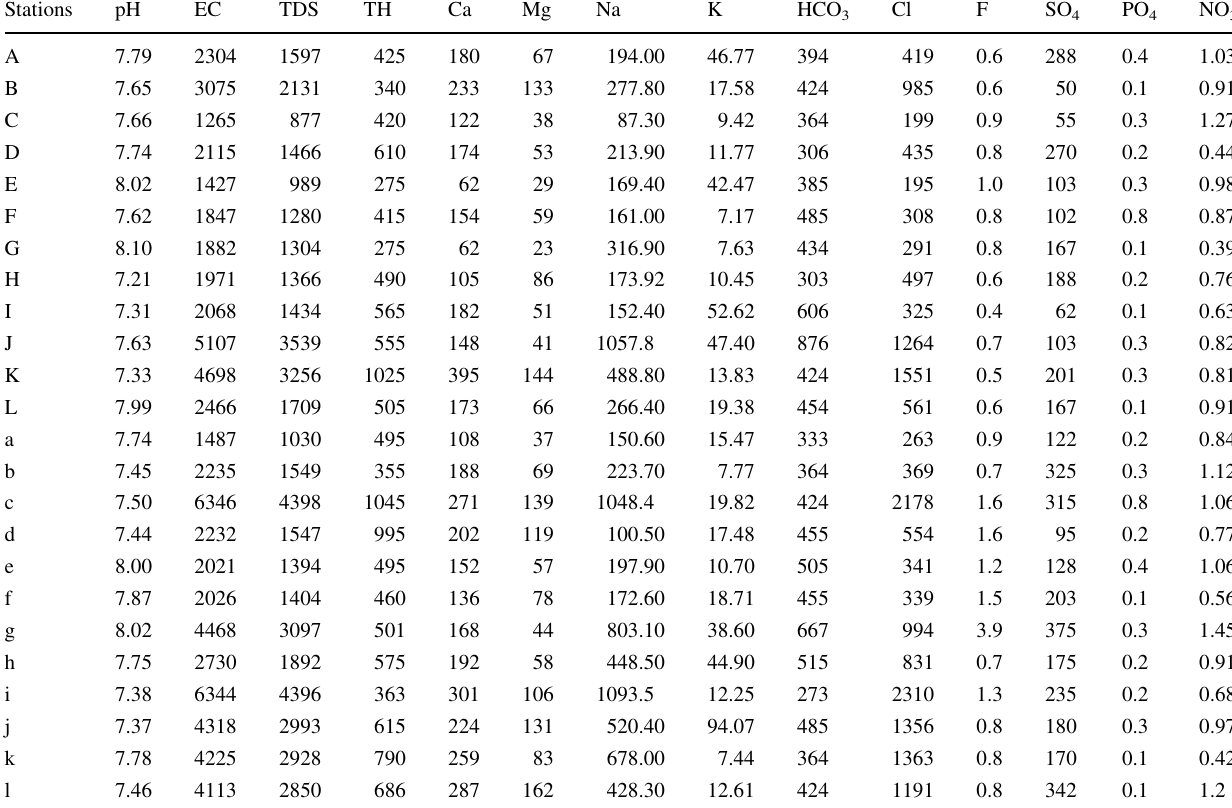
Table 3 Physico-chemical characteristics of the groundwater samples (August 2013)